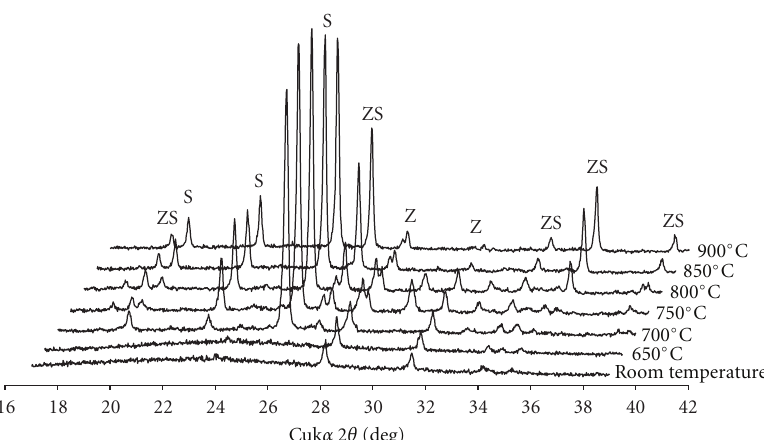
Figure 5: HT-XRD patterns recorded on a powdered sample in the specified temperatures: S: β -LiAl[Si 2 O 6 ]-ss; ZS: ZrSiO 4 ; Z: ZrO 2 .